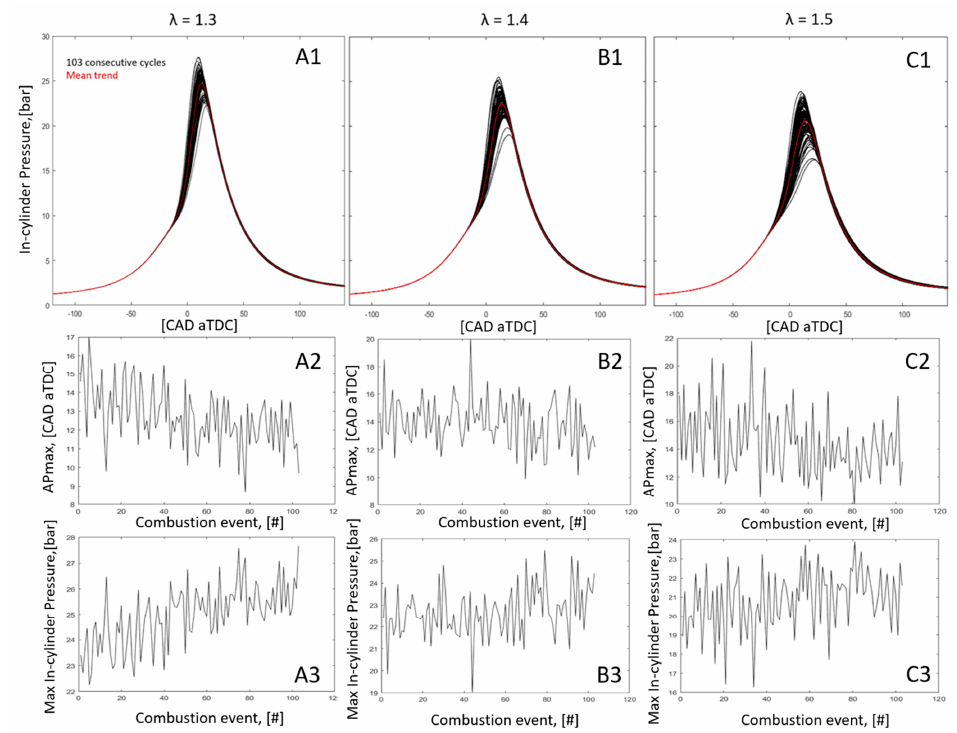
Figure 8. The trends of the in-cylinder pressure ( A1 – C1 ), the distribution of the maximum in-cylinder pressure ( A3 – C3 ) and the corresponding APmax ( A2 – C2 ). The curves have not been given with error bars because the in-cylinder pressure transducer’s accuracy is quite low (see Section 2.1, Optical Access Engine).